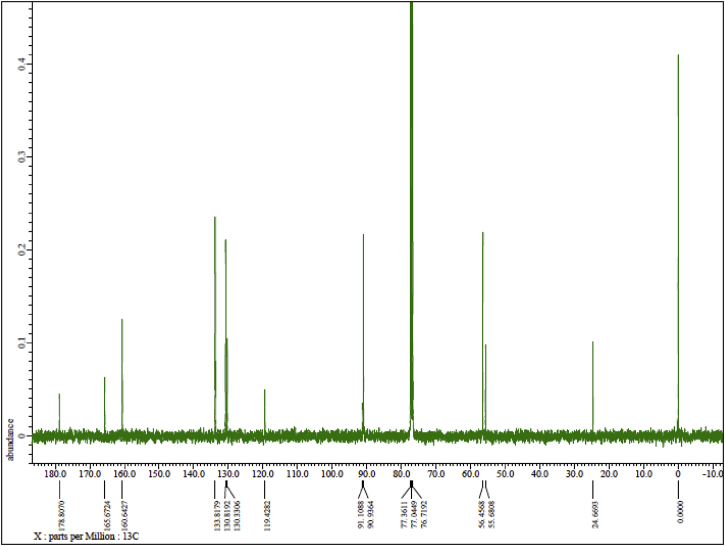
13C NMR spectrum of Ph(TMP)IOAc.